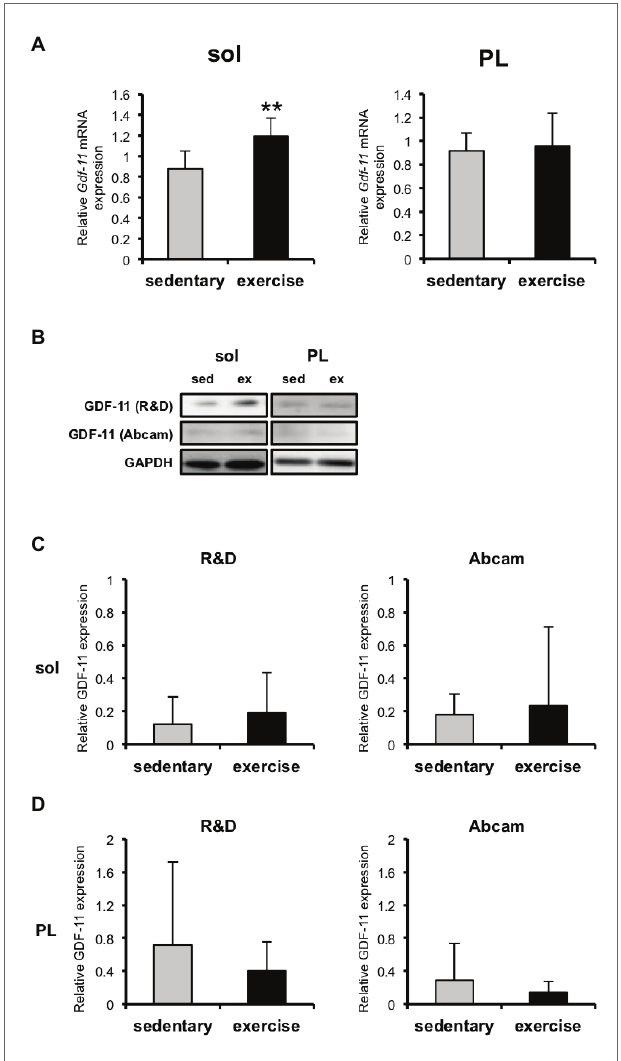
FIGURE 5 | GDF11 mRNA and protein expression levels in skeletal muscles of aged sedentary and exercised mice. (A) Gdf11 mRNA expression in soleus and plantaris of aged sedentary ( n = 5) and aged exercised mice ( n = 6). (B) GDF11 protein detected with western blotting with two different antibodies purchased from R&D Systems and Abcam. (C) Quantitative data for GDF11 protein levels in soleus and plantaris of aged sedentary ( n = 4) and aged exercised mice ( n = 6) detected with the R&D anti-GDF11 antibody. (D) Quantitative data for GDF11 protein levels in soleus and plantaris of aged sedentary ( n = 5) and aged exercised mice ( n = 6) detected with the Abcam anti-GDF11 antibody. Data are presented as means ± SD. ** p < 0.01 vs. the sedentary